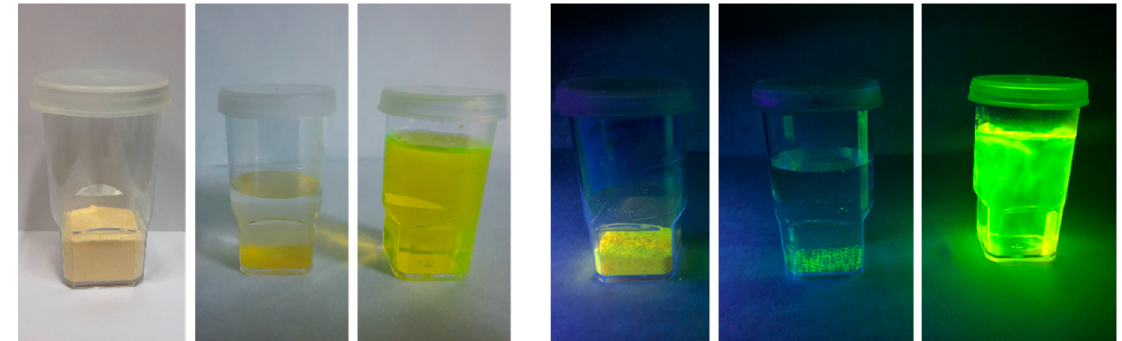
Figure 4. Study of the fluorescing ability of sample CA-fluo0.2: (from left to right within each panel) solid CA-fluo0.2, CA-fluo0.2 in suspension, and fluorescein disodium salt in solution, under (left panel) visible light, and (right panel) under ultraviolet A light (400–315 nm).